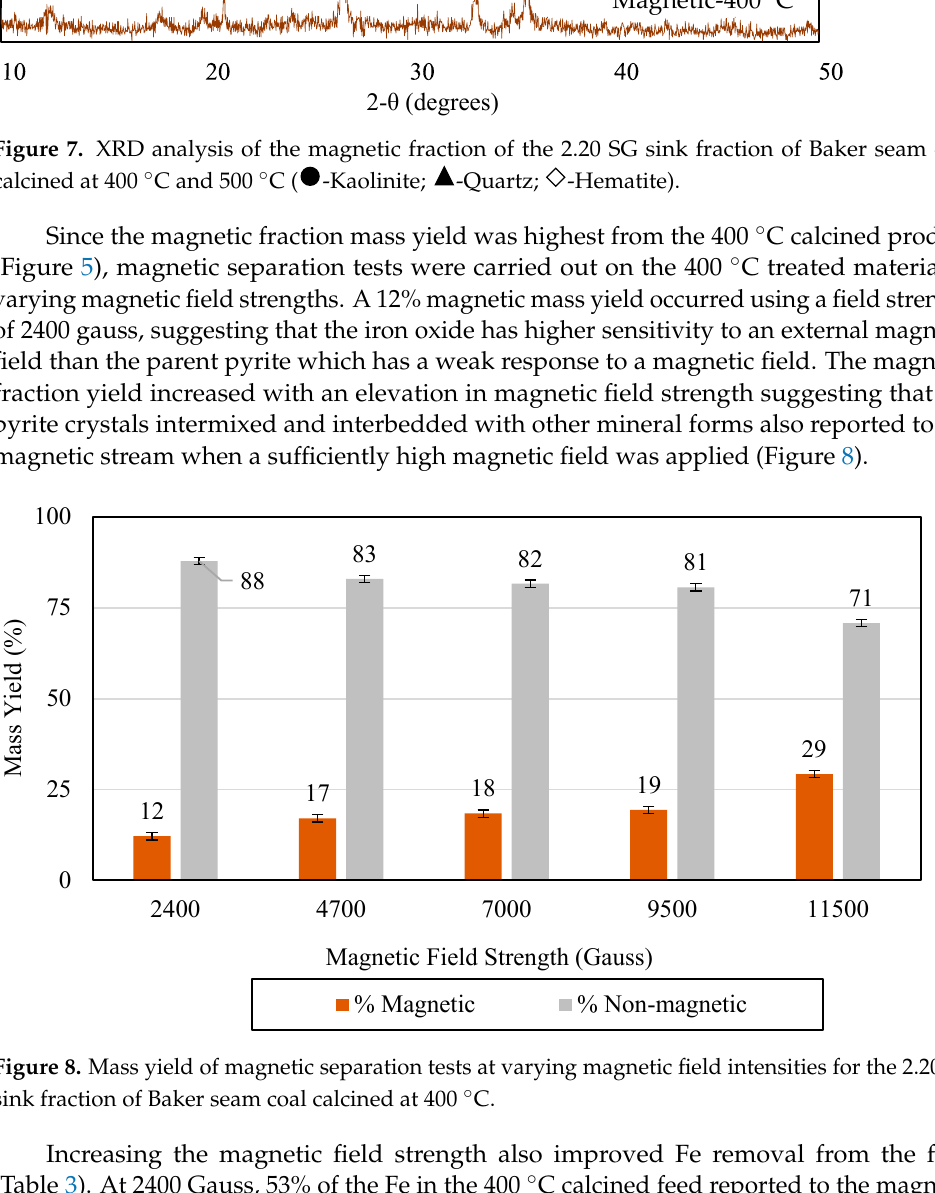
Figure 8. Mass yield of magnetic separation tests at varying magnetic field intensities for the 2.20 SG sink fraction of Baker seam coal calcined at 400 °C.